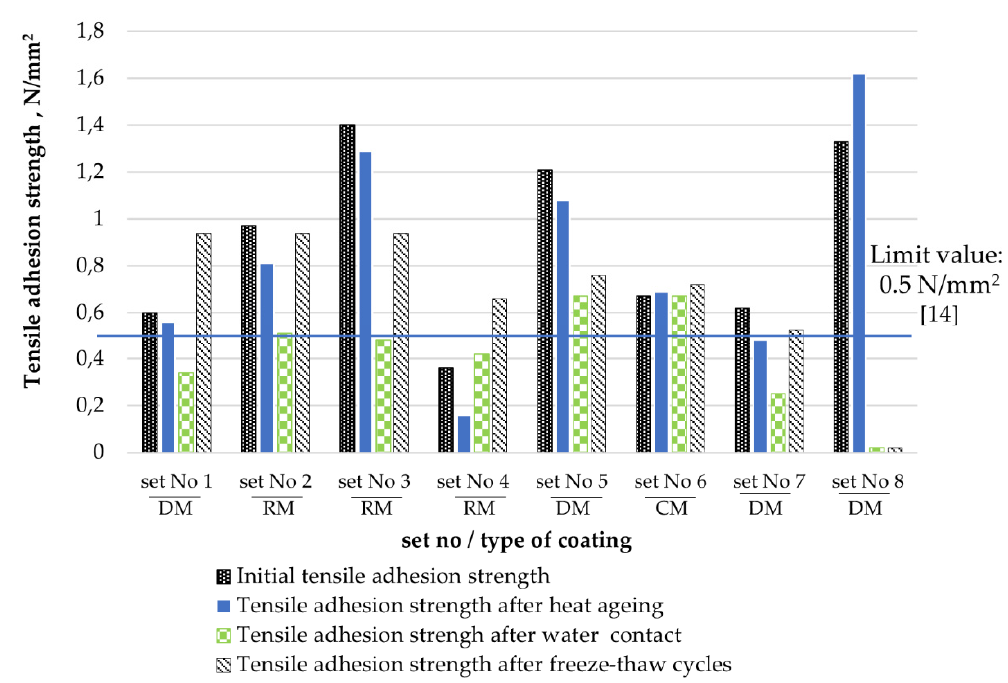
Figure 3. Comparison of initial tensile adhesion strength of waterproofing sets, following exposure to selected ageing factors.